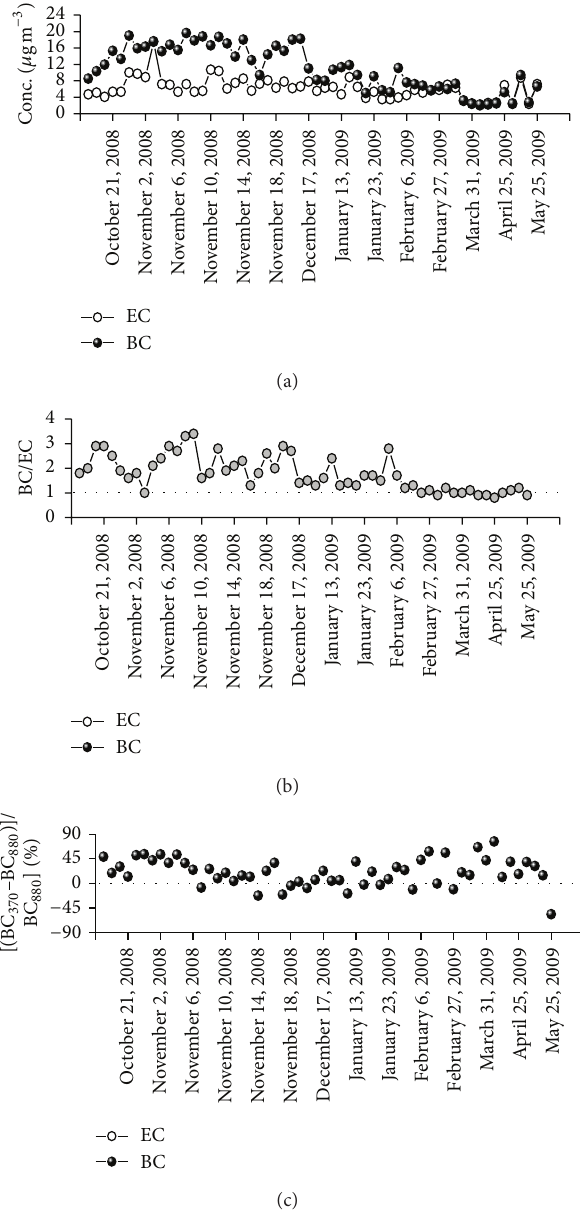
Figure 2: Temporal variability in the: (a) mass concentrations of BC and EC; (b) BC-to-EC ratio and; (c) percentage contribution of BC measured at 370 nm and 880 nm for different emissions during the study period from October 2008 to May 2009.